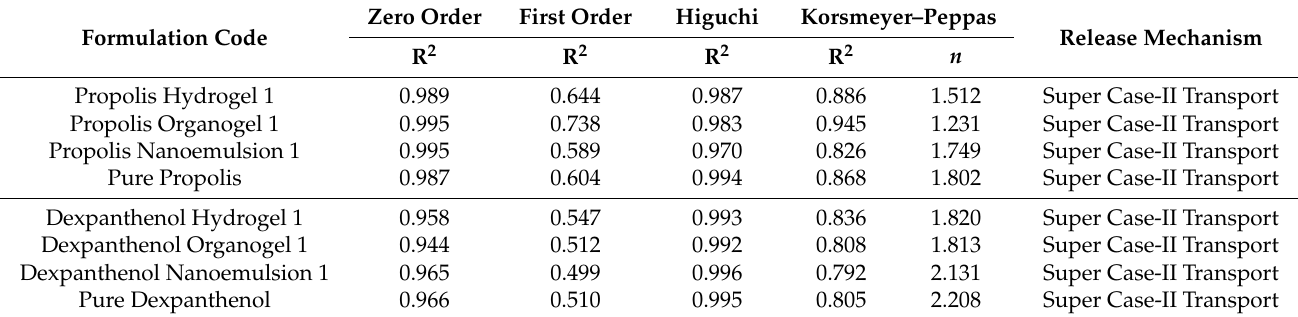
Table 7. Release kinetics and mechanisms of propolis and dexpanthenol.